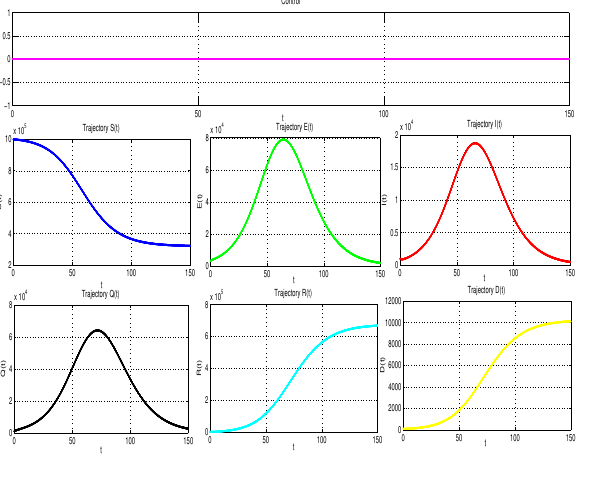
Figure 6. Evolution of stats without vaccine, after 150 days.